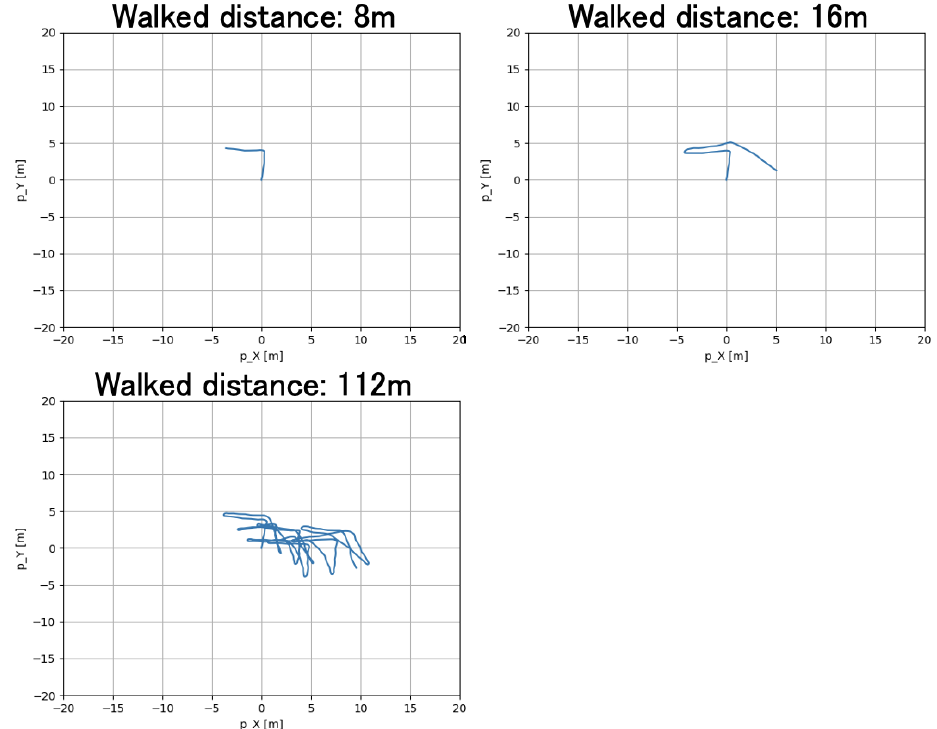
Figure 16. The results of route